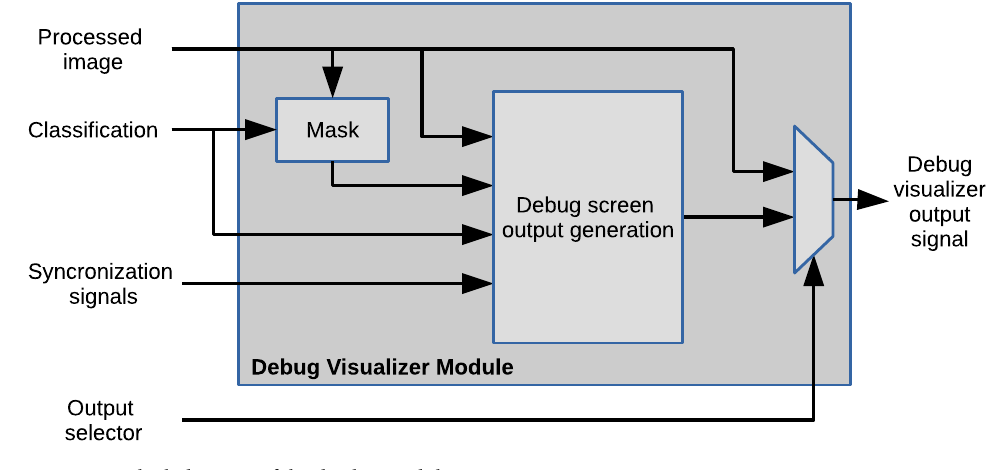
Figure 6. Block diagram of the display